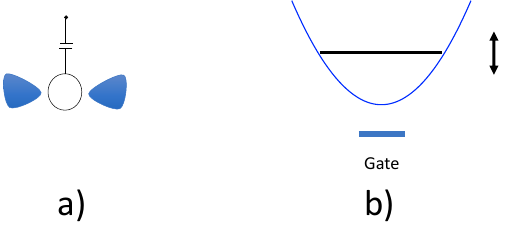
Figure 3: Left: single quantum dot with the noisy back gate. Right: quantum well with fluctuating energy